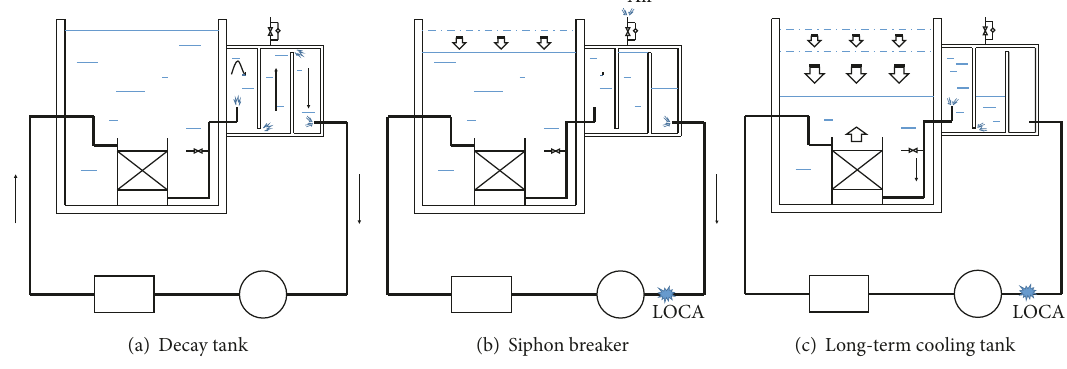
Figure 4: Operation modes of integrated passive safety